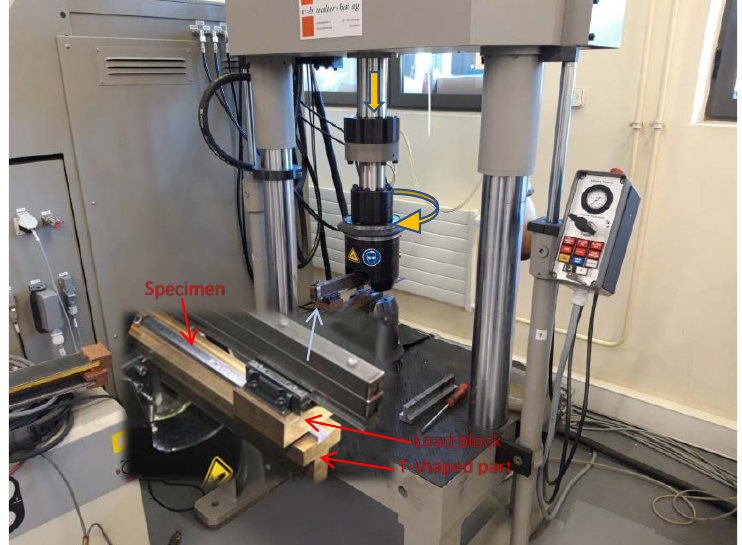
Figure 1. Testing equipment.